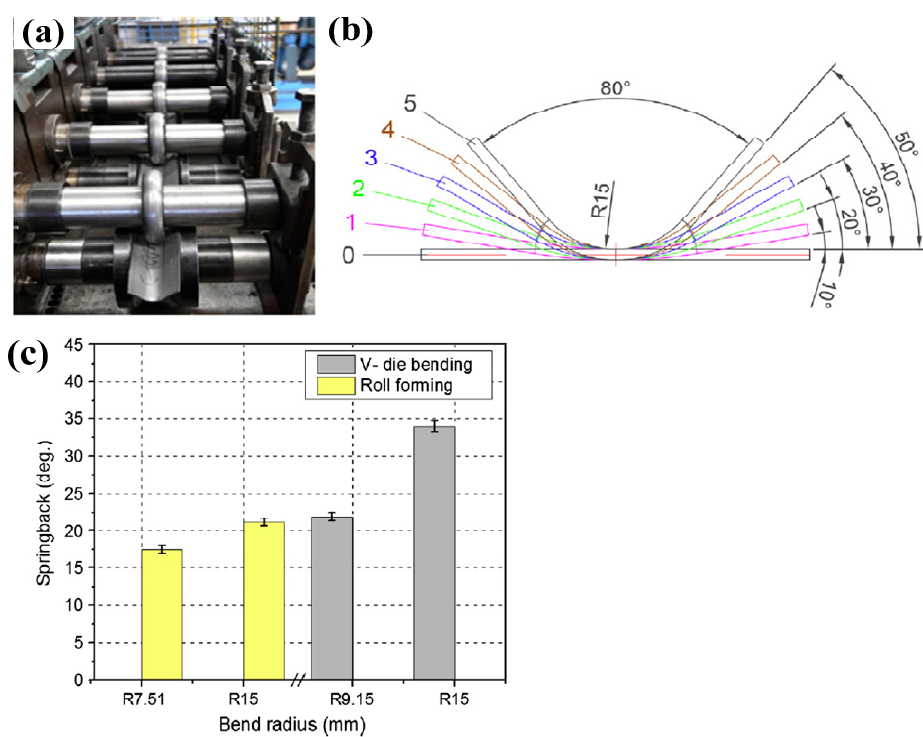
Figure 15. ( a ) Forming tools for roll forming of Ti-6Al-4V sheet, ( b ) flower pattern for the V-profile roll forming with R15 radius and ( c ) springback comparison between V-die-bending and roll forming [112]. Reprinted with permission from Ref. [112]. Copyright 2015, Mater. Design.